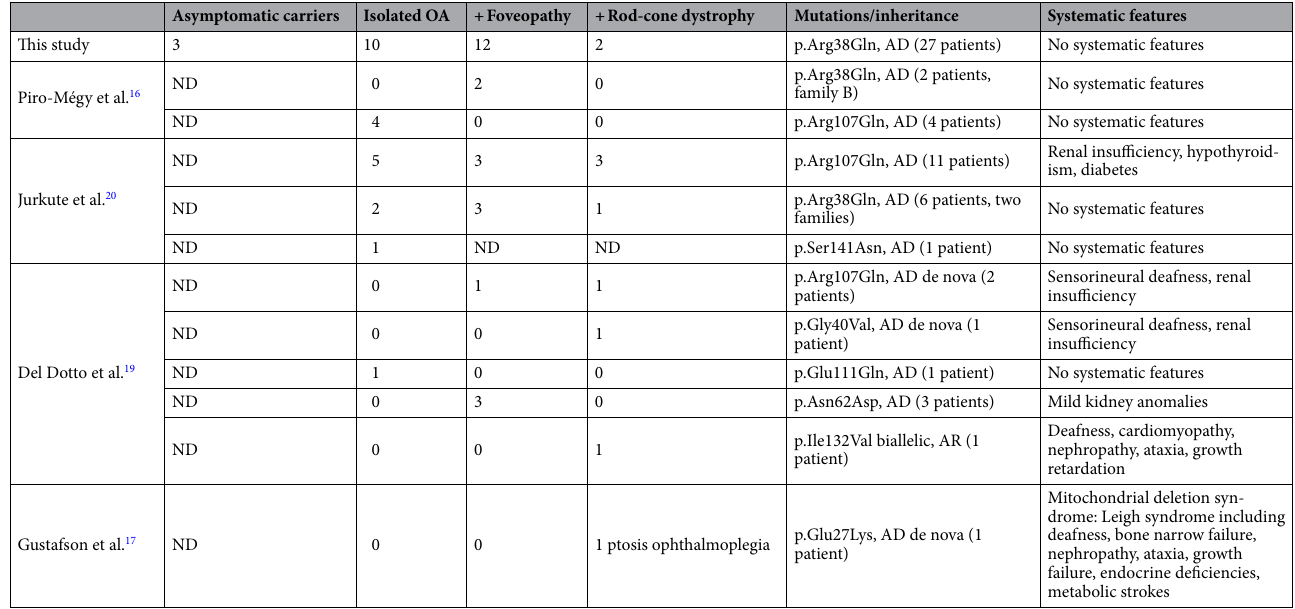
Table 1. Summary of the clinical data from the published SSBP1 patients. AD autosomal dominant, AR autosomal recessive, ND not